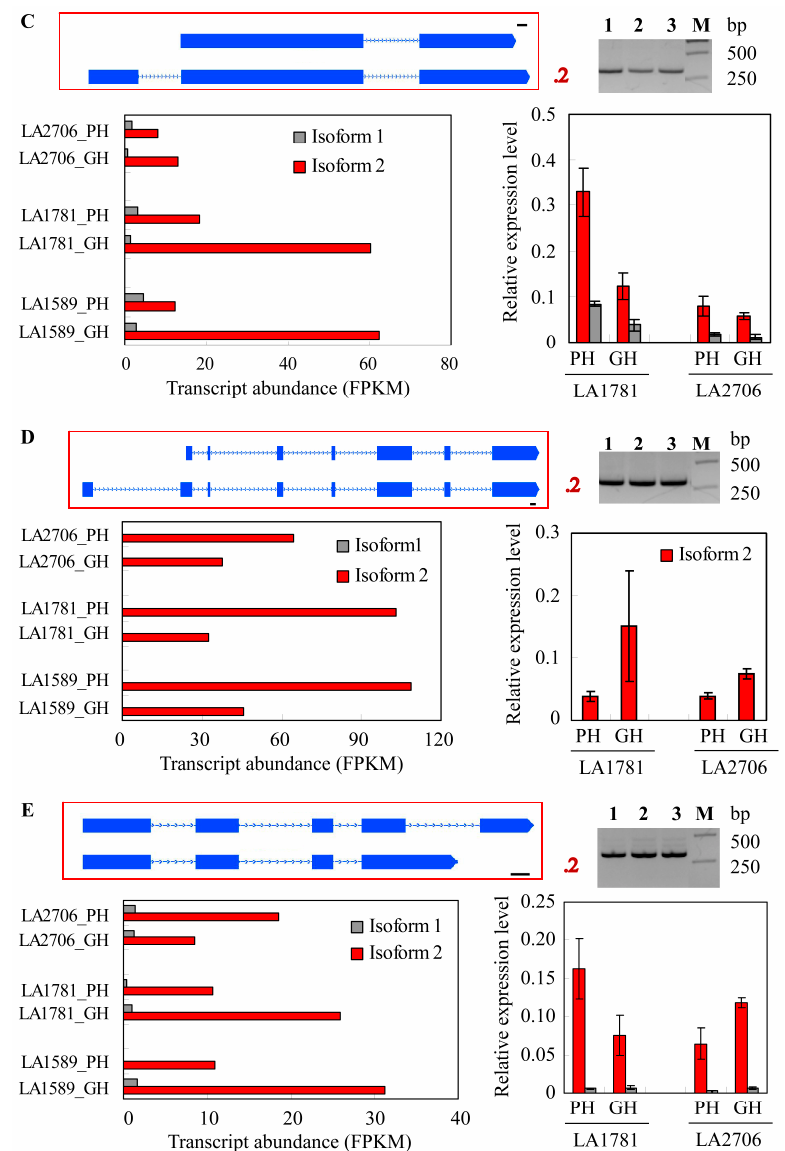
Figure 5. Validation of five isoforms showing differential expression in response to distinct growth conditions. The differentially expressed transcript isoforms of genes encoding a CCT (CONSTANS, CO-like, and TOC1) motif family protein ( Solyc03g083400 , ( A )); a R2R3 MYB transcription factor ( Solyc05g008240 , ( B )); the ethylene receptor ETR4 ( Solyc06g053710 , ( C )); Protein-P-II uridylyltransferase ( Solyc06g059800 , ( D )) and Aluminum-induced protein-like ( Solyc02g078500 , ( E )) were verified by RT-PCR and qRT-PCR using total RNA samples collected from GH and PH grown seedlings at 5 days post germination. In ( A – E ), the upper panel is showing the intron–exon structures of the two isoforms (left) and agarose gel images of RT-PCR analysis using isoform-specific primers (right). The lower panel is showing the transcript abundance revealed by RNA-seq (left) and qRT-PCR (right). The splice variants were labeled as .2 (isoform 2), whereas the annotated transcripts (isoform 1) were indicated by .1 (in A , B ) or not particularly labeled (in C – E ) at the right side of the gene structures, which introns and exons are represented by dotted lines and blue boxes. The numbers 1, 2 and 3 above each gel image in ( A – E ) represent cDNA samples from LA1589, LA1781 and LA2706 seedlings. M, the DNA marker with the band sizes, is indicated at the right side.